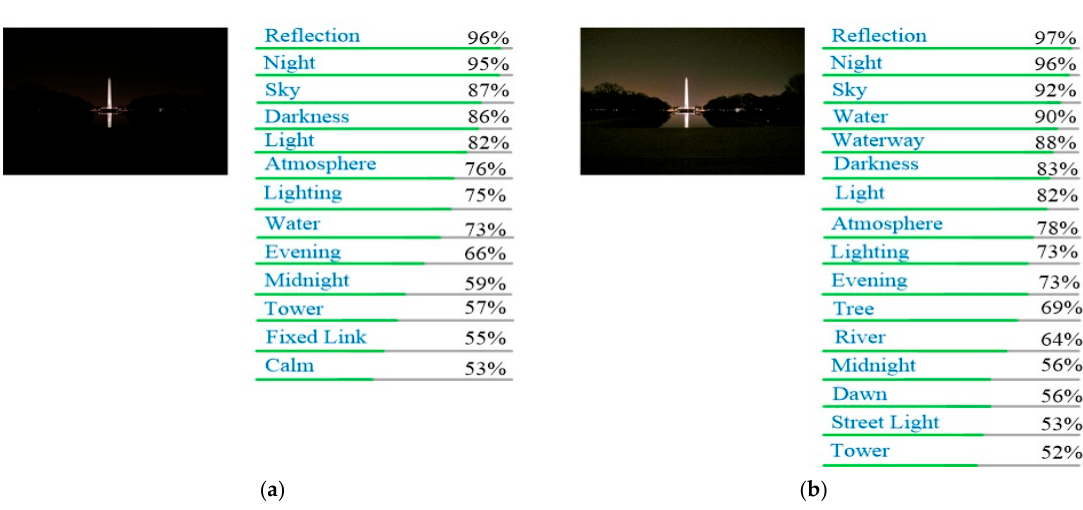
low-light image; ( b ) Recognizing result of our enhanced image.